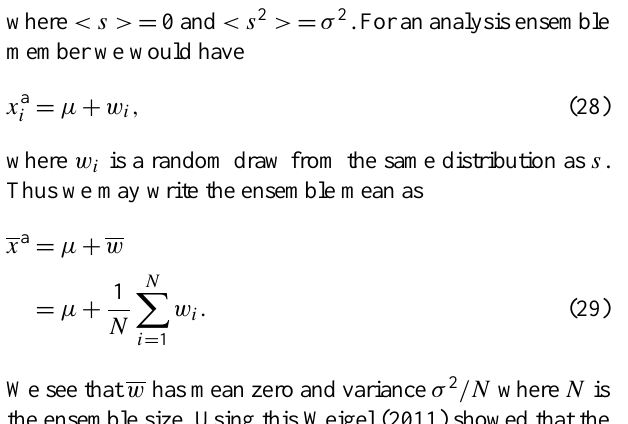
Figure 3. RMS error and ensemble spread of the forecast and anal- ysis using the logistic model, as a function of the background error standard deviation used in calculating the analysis. The ensembles were created by each ensemble member using the same assimilation method, assimilating perturbed observations.